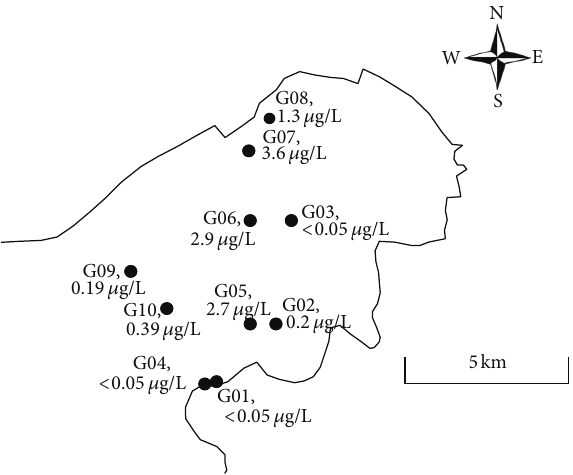
Figure 3: Microcystin distributions in Gonghu